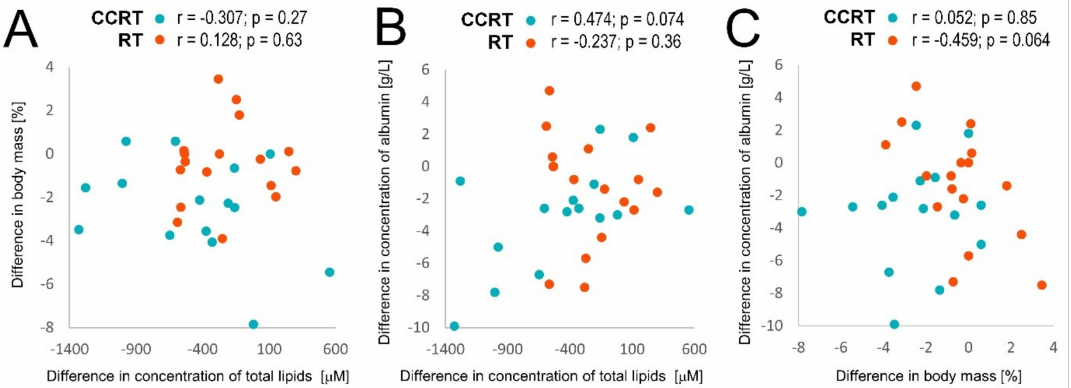
Figure6. Correlationsbetweenindividualtreatment-relatedchangesoftotalphospholipidconcentration (PC, lysoPC, and SM), serum albumin concentration, and body mass during the first stage of a treatment (the B-A di ff erence) in CCRT and RT samples marked in blue and orange, respectively. Denoted are the correlation coe ffi cient (r) and its p-value for each patients’ group. Showed are: correlations between changes in body mass and concentration of total serum lipids ( A ), correlations between changes in concentration of serum albumin and total serum lipids ( B ), correlations between changes in concentration of serum albumin and body mass ( C